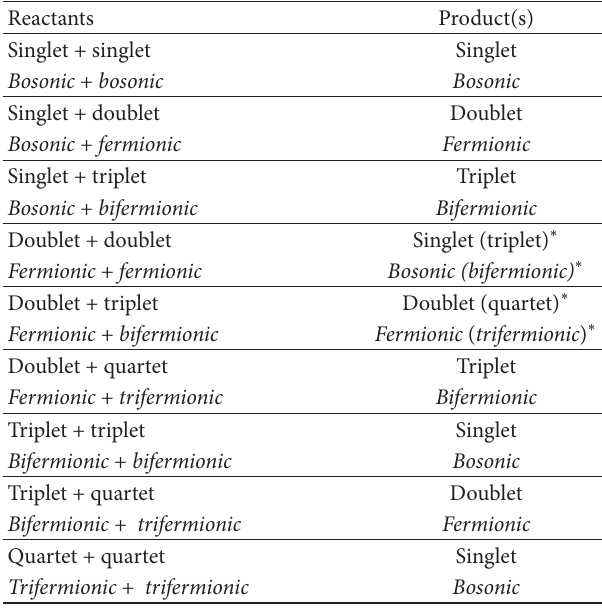
Table 1: Spin conservation rules. Multiplicity states from the perspective of the bosonic-fermionic orbital character of reactants and